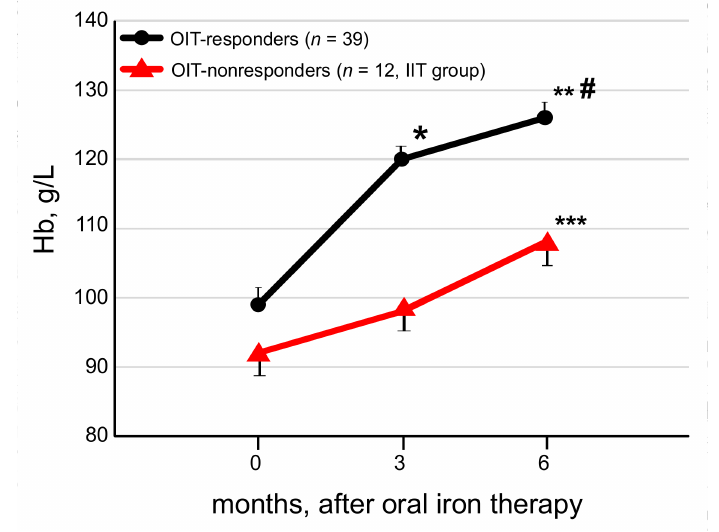
Figure 2. Change of Hb levels in OIT-responders and OIT-nonresponders. The Hb levels were increased at 3 and 6 months after OIT in OIT-responders. In OIT-nonresponders, the Hb levels remained unchanged at 3 months after OIT but increased with IIT at the end of the study as a whole IIT-group. Data are expressed as mean ± standard error of the mean (SEM). Comparison of two nonparametric data groups was analyzed by the Mann-Whitney U test. * p < 0.01, vs. data at 0 month, ** p < 0.01, vs. data at 3 months, *** p < 0.05, vs. data at 3 months, # p < 0.05, vs.